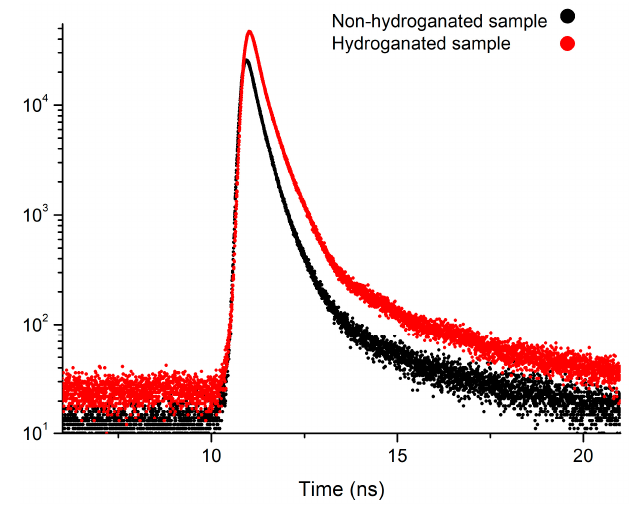
Figure 9. Positron annihilation lifetime spectra measured for non-hydrogenated and hydrogenated nanodiamond samples.